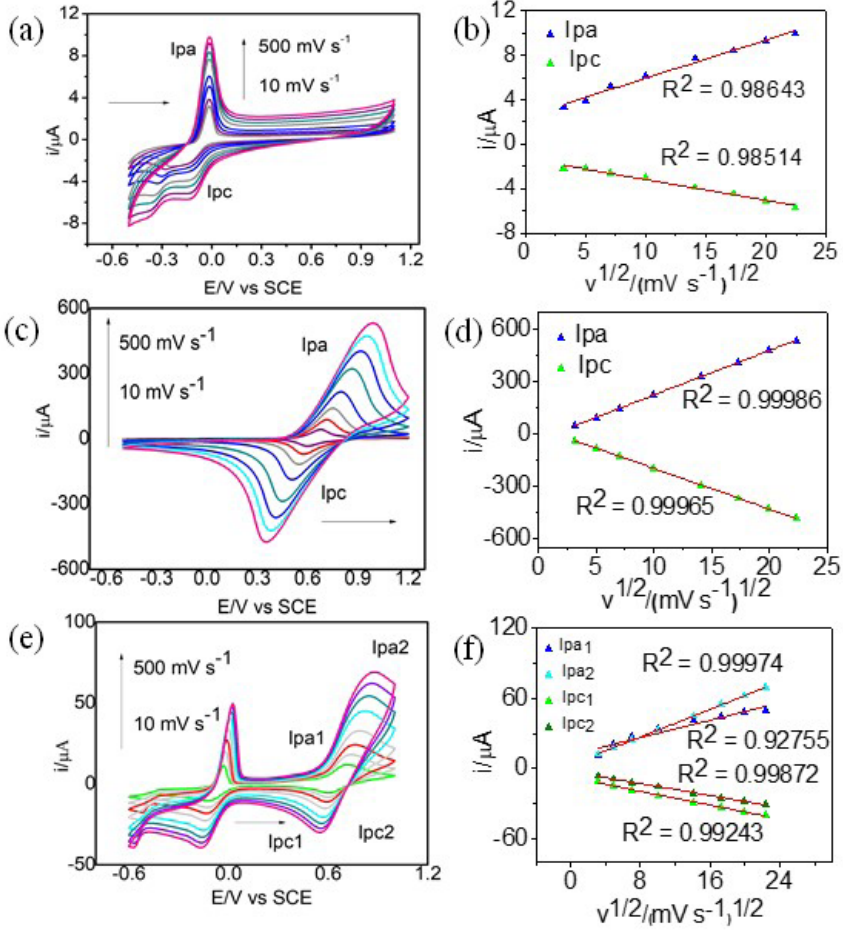
Figure 4. Cyclic voltammograms for glassy carbon electrodes modified with (a) CuO NPs, (c) Cu [Fe(CN) ] 2 6 complex, and the (e) nanocomposite, with scan rate of 10 to 500 mV s -1 in acetate buffer (pH = 4.1) and (b), (d) e (f) study of linearity of currents as a function of v 1/2